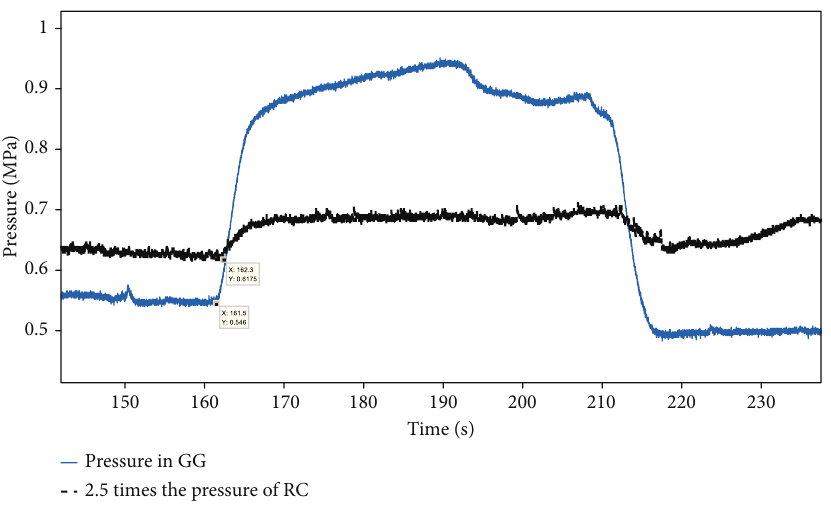
Figure 6: Variation trends of H and H